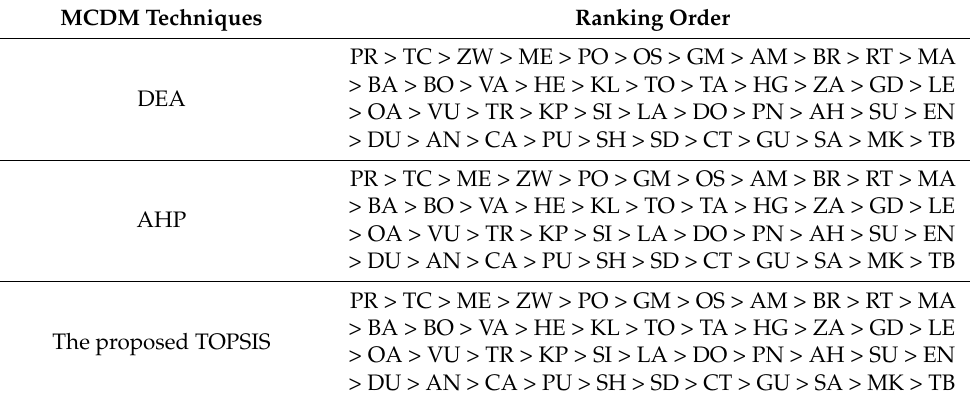
Table 8. Comparison with other